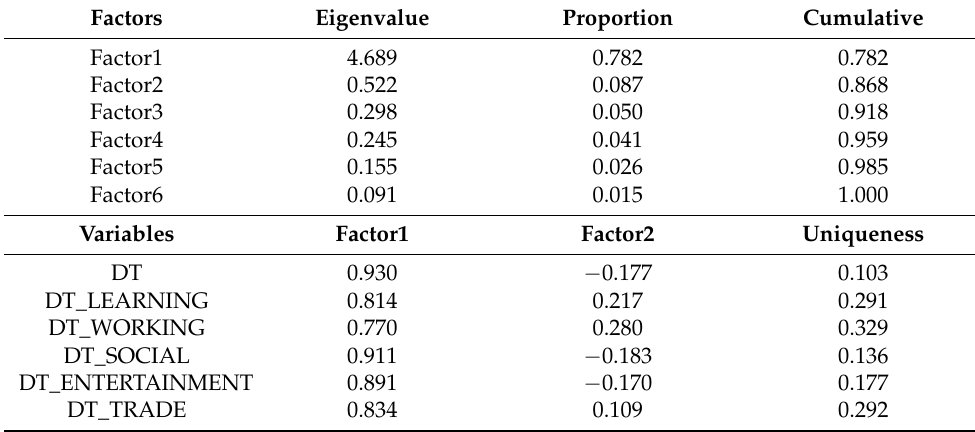
Table 2. Relevant test values for the PCA